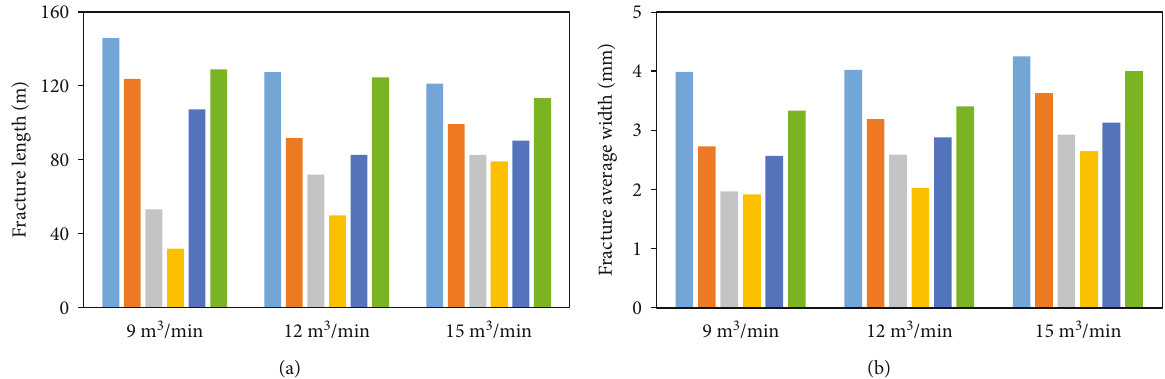
Figure 10: Length (a) and average width (b) of multifracture in a stage with di ff erent fl ow